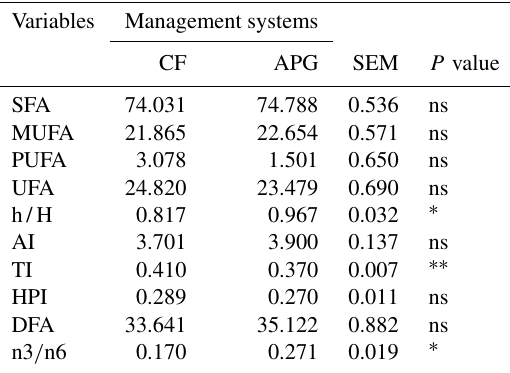
Table 4. Milk nutritional indices of the Awassi ewes in the CF and APG management systems. Variables Management